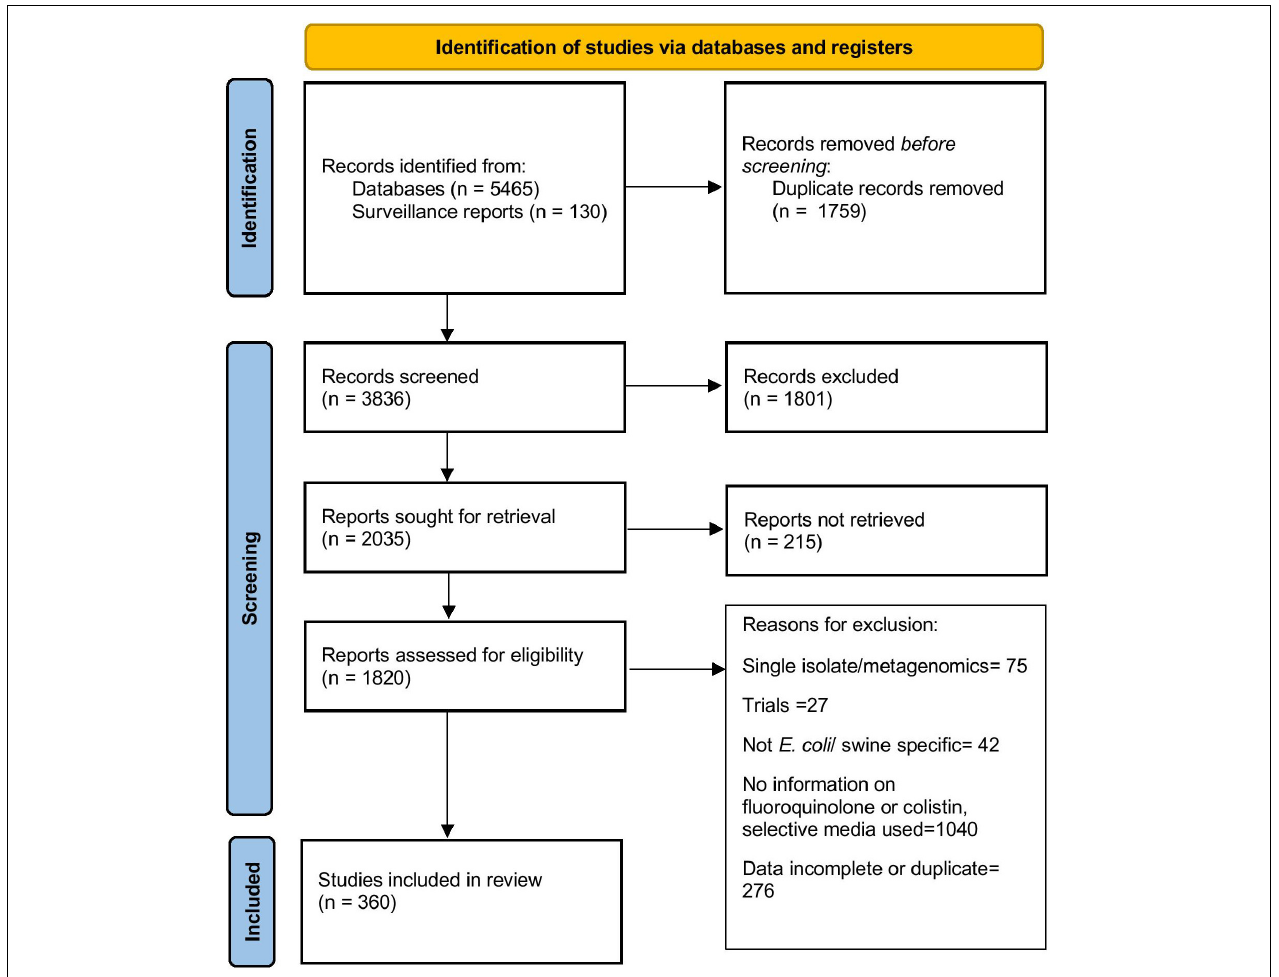
FIGURE 1 | Flowchart describing selection of articles included in this